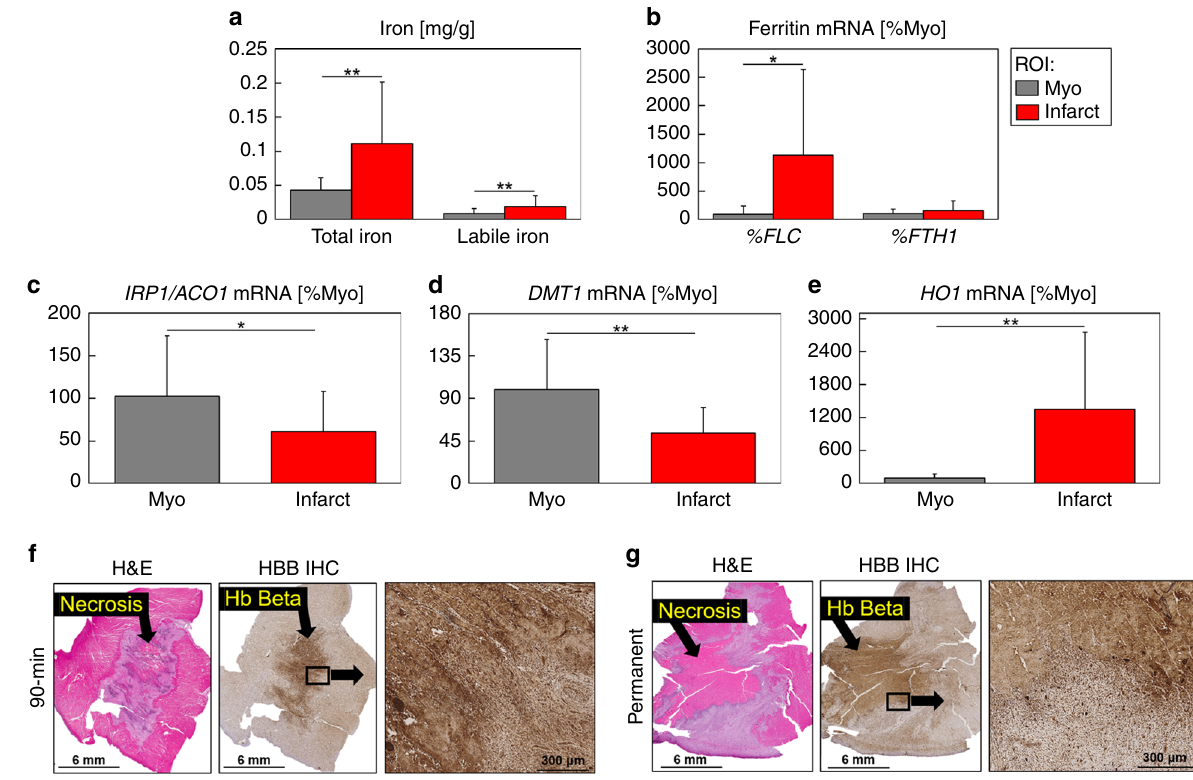
Fig. 2 Ex vivo iron content and expression of cellular markers of iron homeostasis. a Infarcts had signi fi cantly increased total iron ( P = 7e − 22) and labile iron ( P = 3e − 4) concentration compared with remote (myo) regions. Myo ( n = 188) and infarct ( n = 216) total iron ICP-OES and myo ( n = 25) and infarct ( n = 43) labile iron EPR measurements were from independent tissue samples. b Ferritin light chain ( FLC ) expression was signi fi cantly increased in